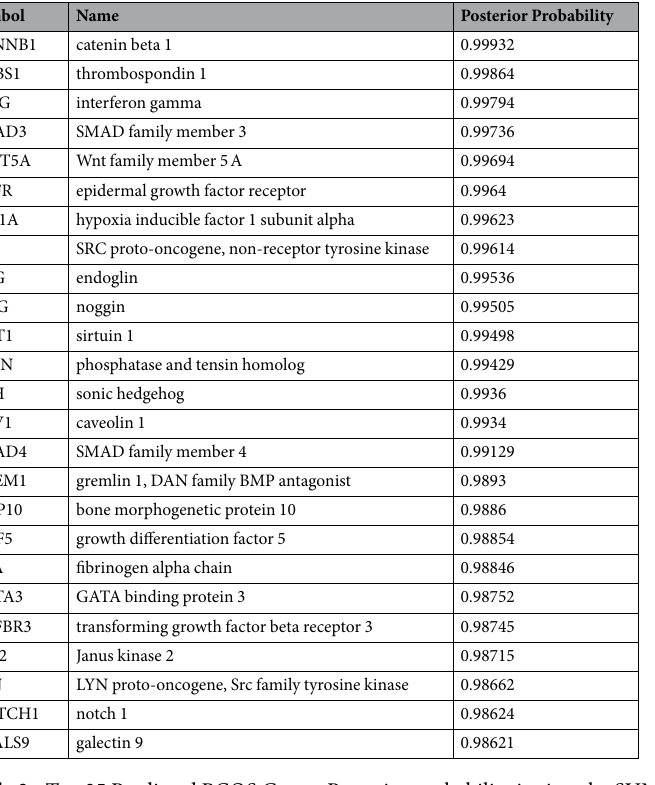
Table 3. Top 25 Predicted PCOS Genes. Posterior probability is given by SVM to evaluate the reliability of the prediction. SVM represents support vector